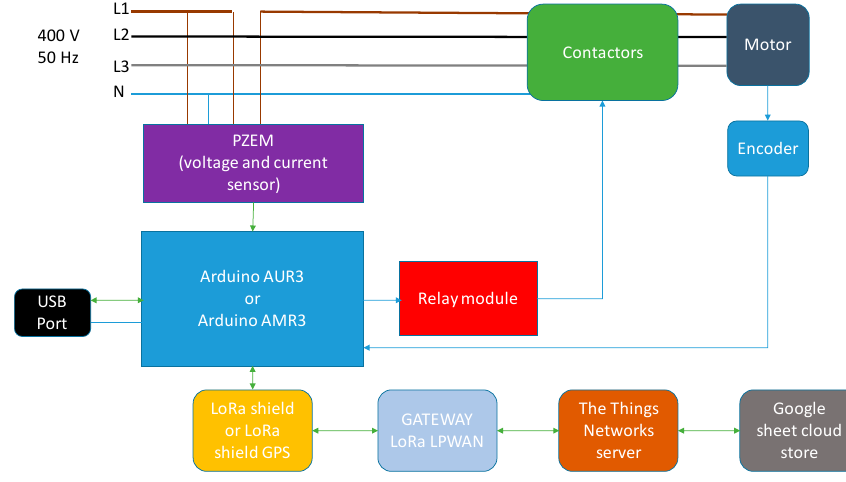
Figure 3. Hardware block diagram of IMEMSL.